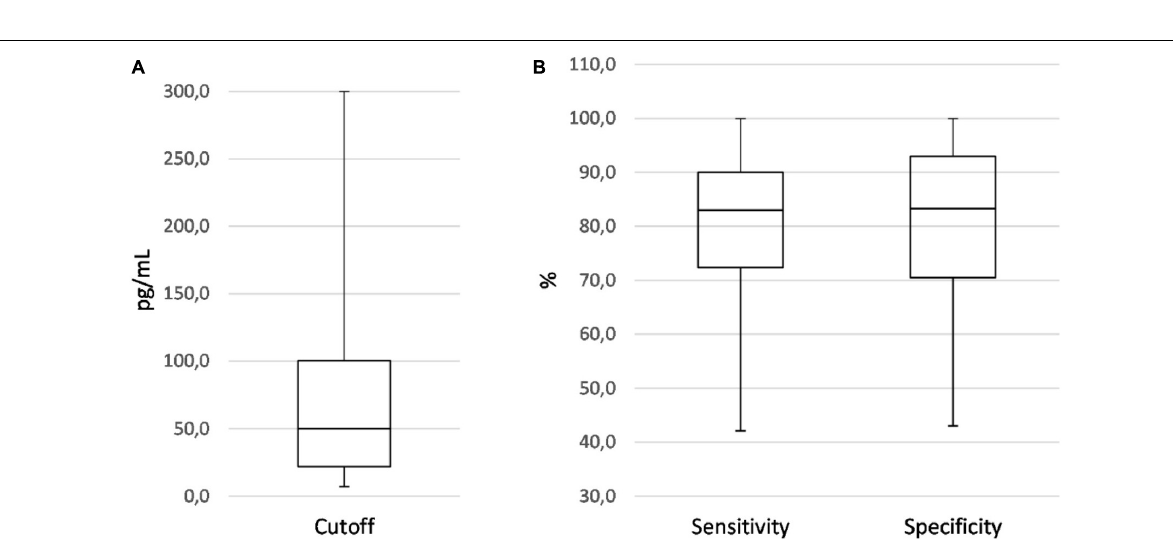
Frontiers in Pediatrics |